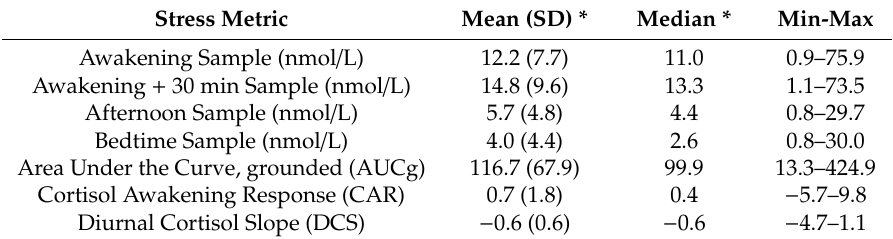
Figure 2. Mean cortisol values for 24 h collection. Table 2. Descriptive statistics of biological stress metrics.